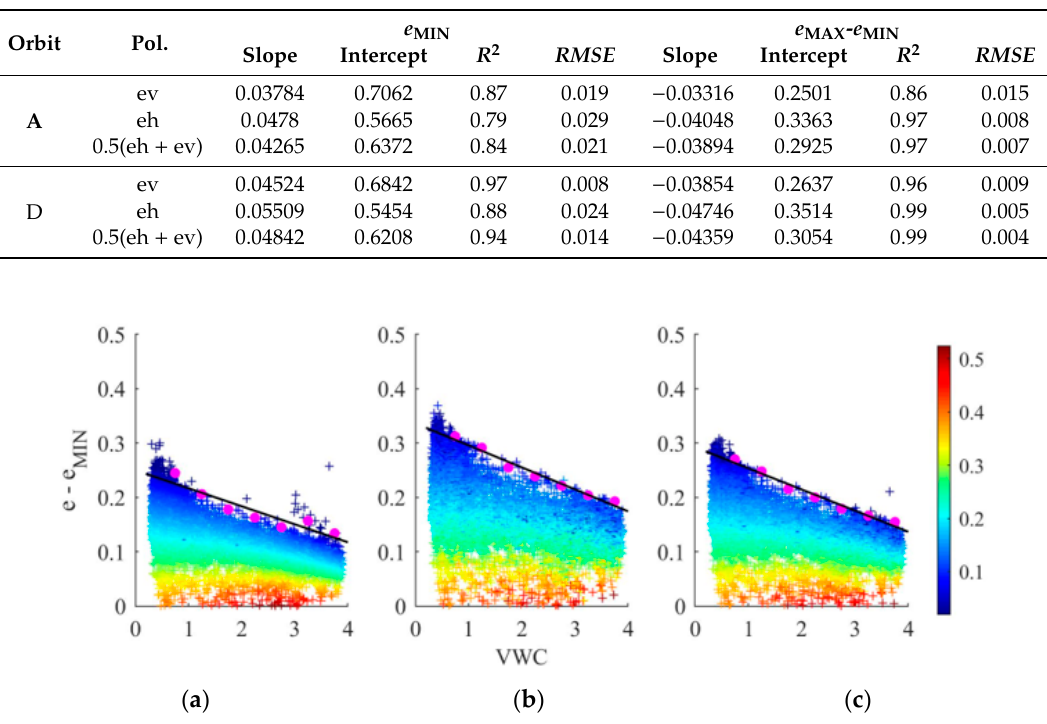
Table 1. Fitted linear relationships between VWC and e MIN ( e MAX − e MIN ), and corresponding fitted parameters ( R 2 , RMSE—root mean squared error) derived from SMAP ascending and descending L3 SSM datasets for an agricultural area in northeast China from 2016–2018.